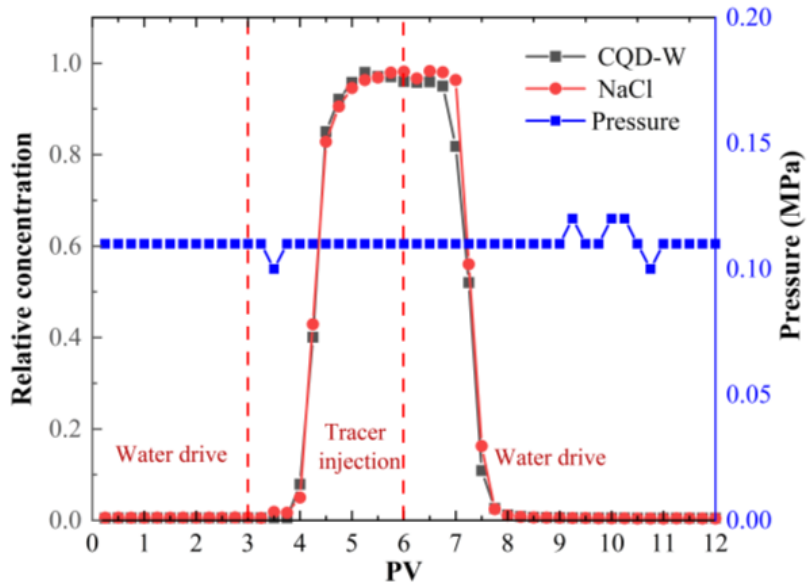
Figure 12. Relative concentration and internal pressure versus injection volume.